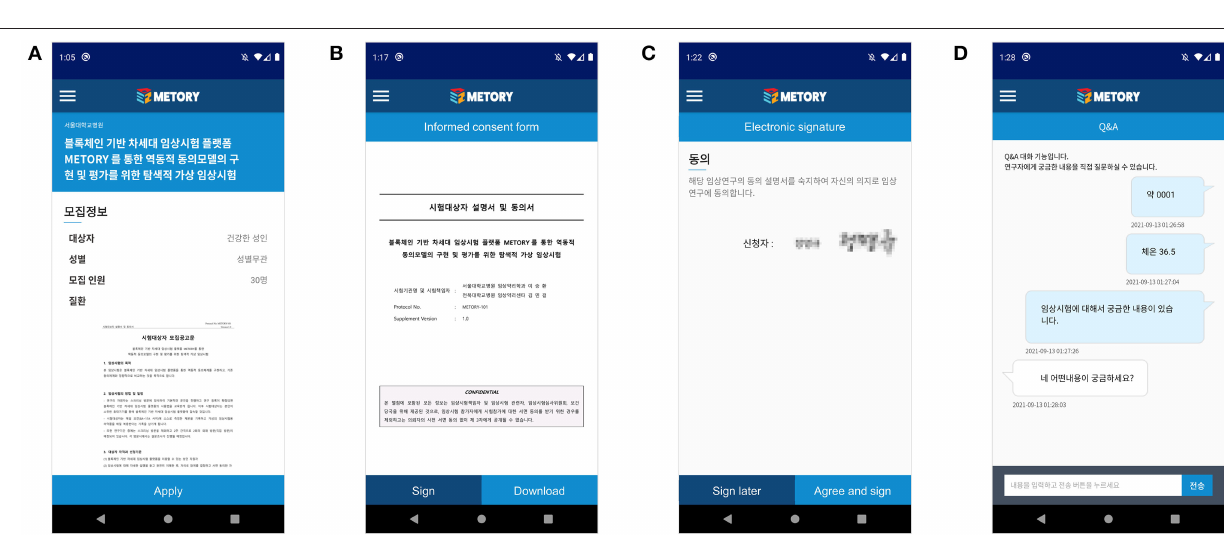
FIGURE 5 | Mobile application interface of the consent process: participation in a study (A) , access to the informed consent form (B) , electronic signature (C) , and chat-ting module between the subject and the investigator (D)